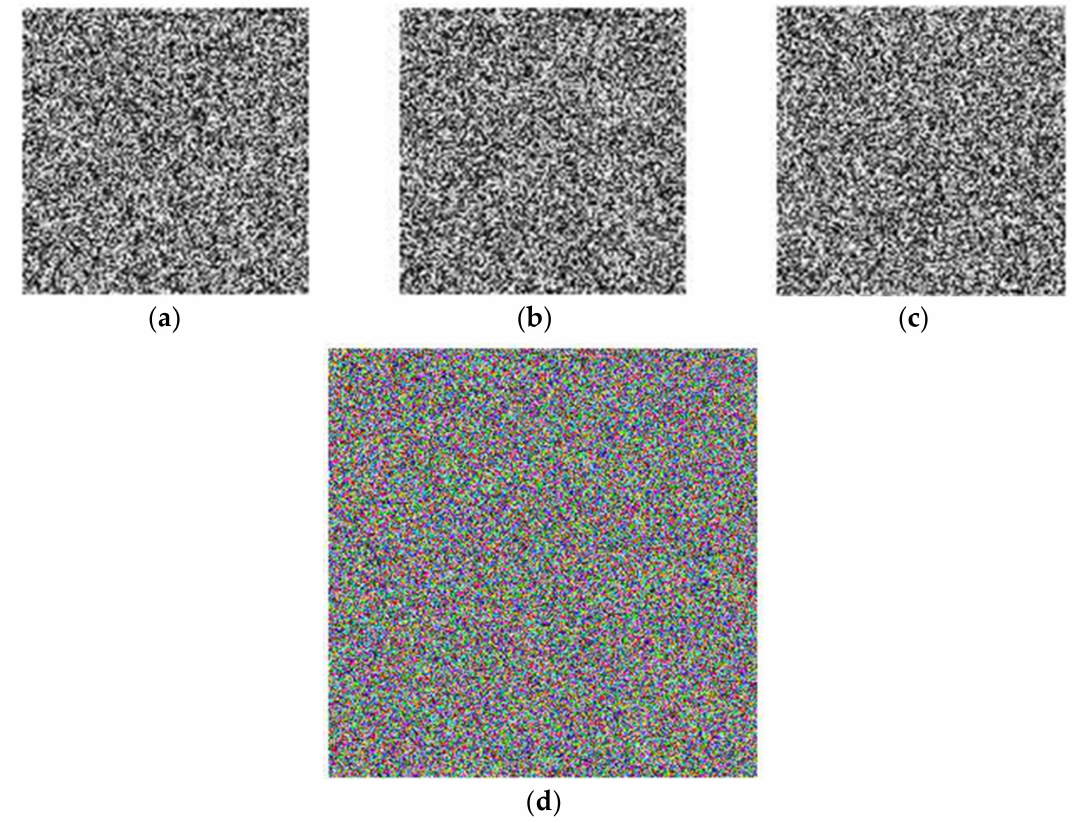
Figure 8. Experimental data: ( a – c ) corresponding decrypted image of 30th, 70th and 100th band with a = 2; ( d ) decrypted image combined of ( a – c